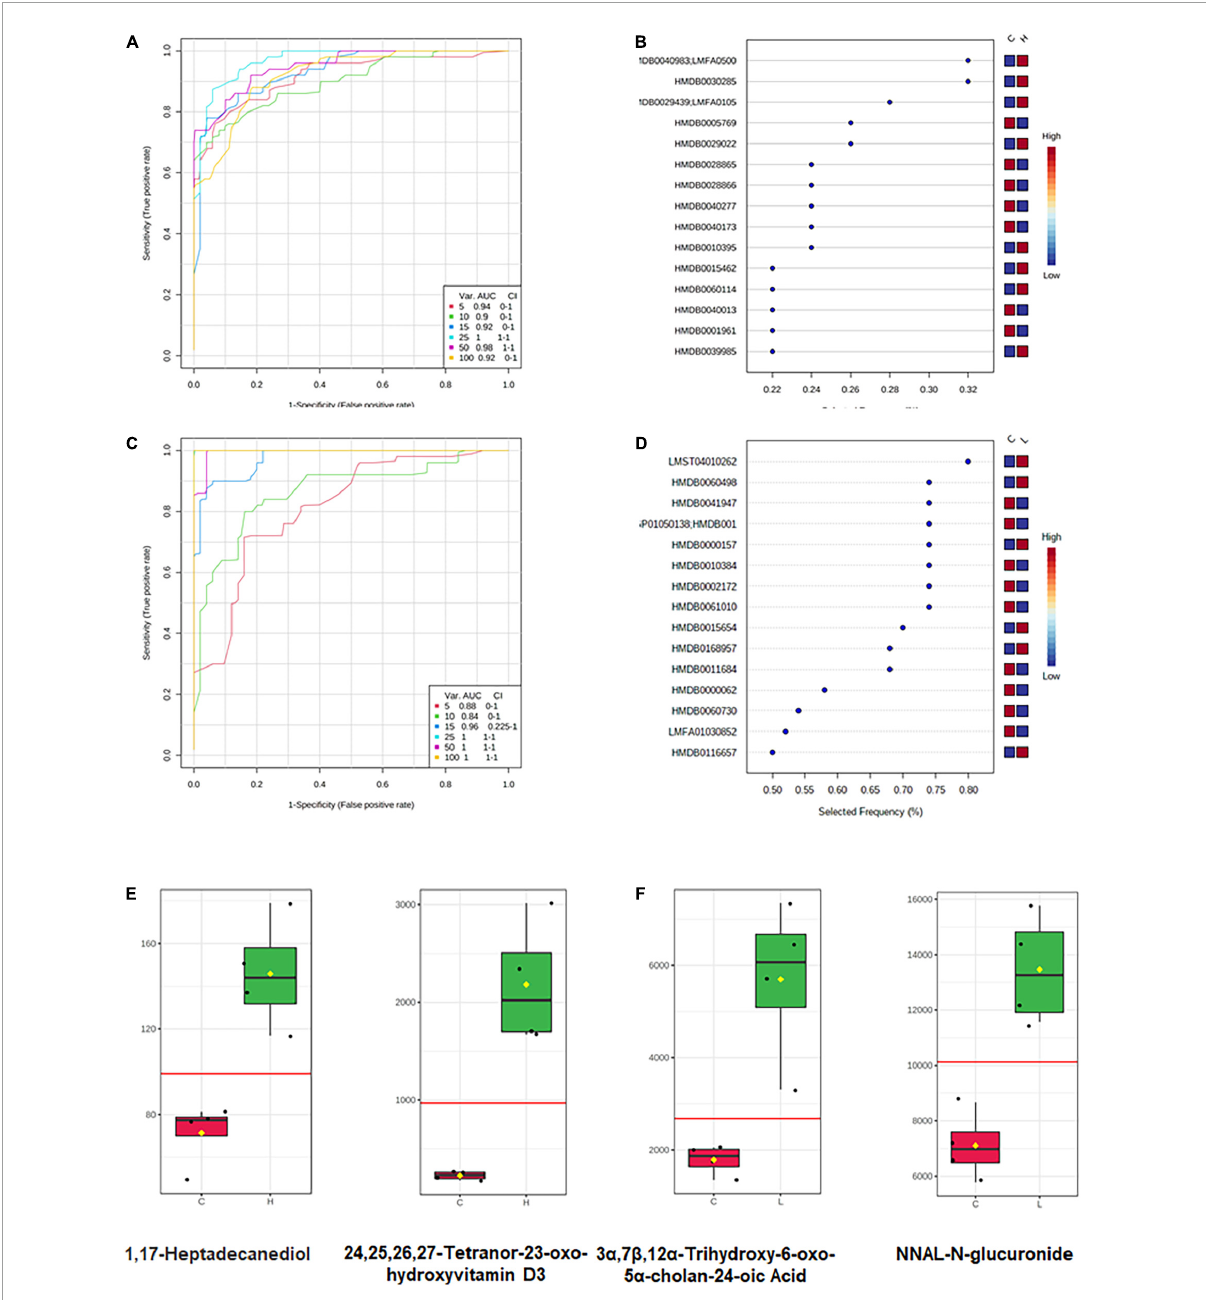
FIGURE8 Metabolic biomarker analysis of CRC and inflammation. (A) ROC curve analyses based on random forests algorithms for biomarker analysis in CRC. (B) Top 15 metabolites discriminating CRC from health. (C) ROC curve analyses based on random forests algorithms for biomarker analysis in inflammation. (D) Top 15 metabolites discriminating inflammation from health. (E) Candidate metabolic biomarkers of CRC screened out by statistical analysis. (F) Candidate metabolic biomarkers of inflammation screened out by statistical analysis.